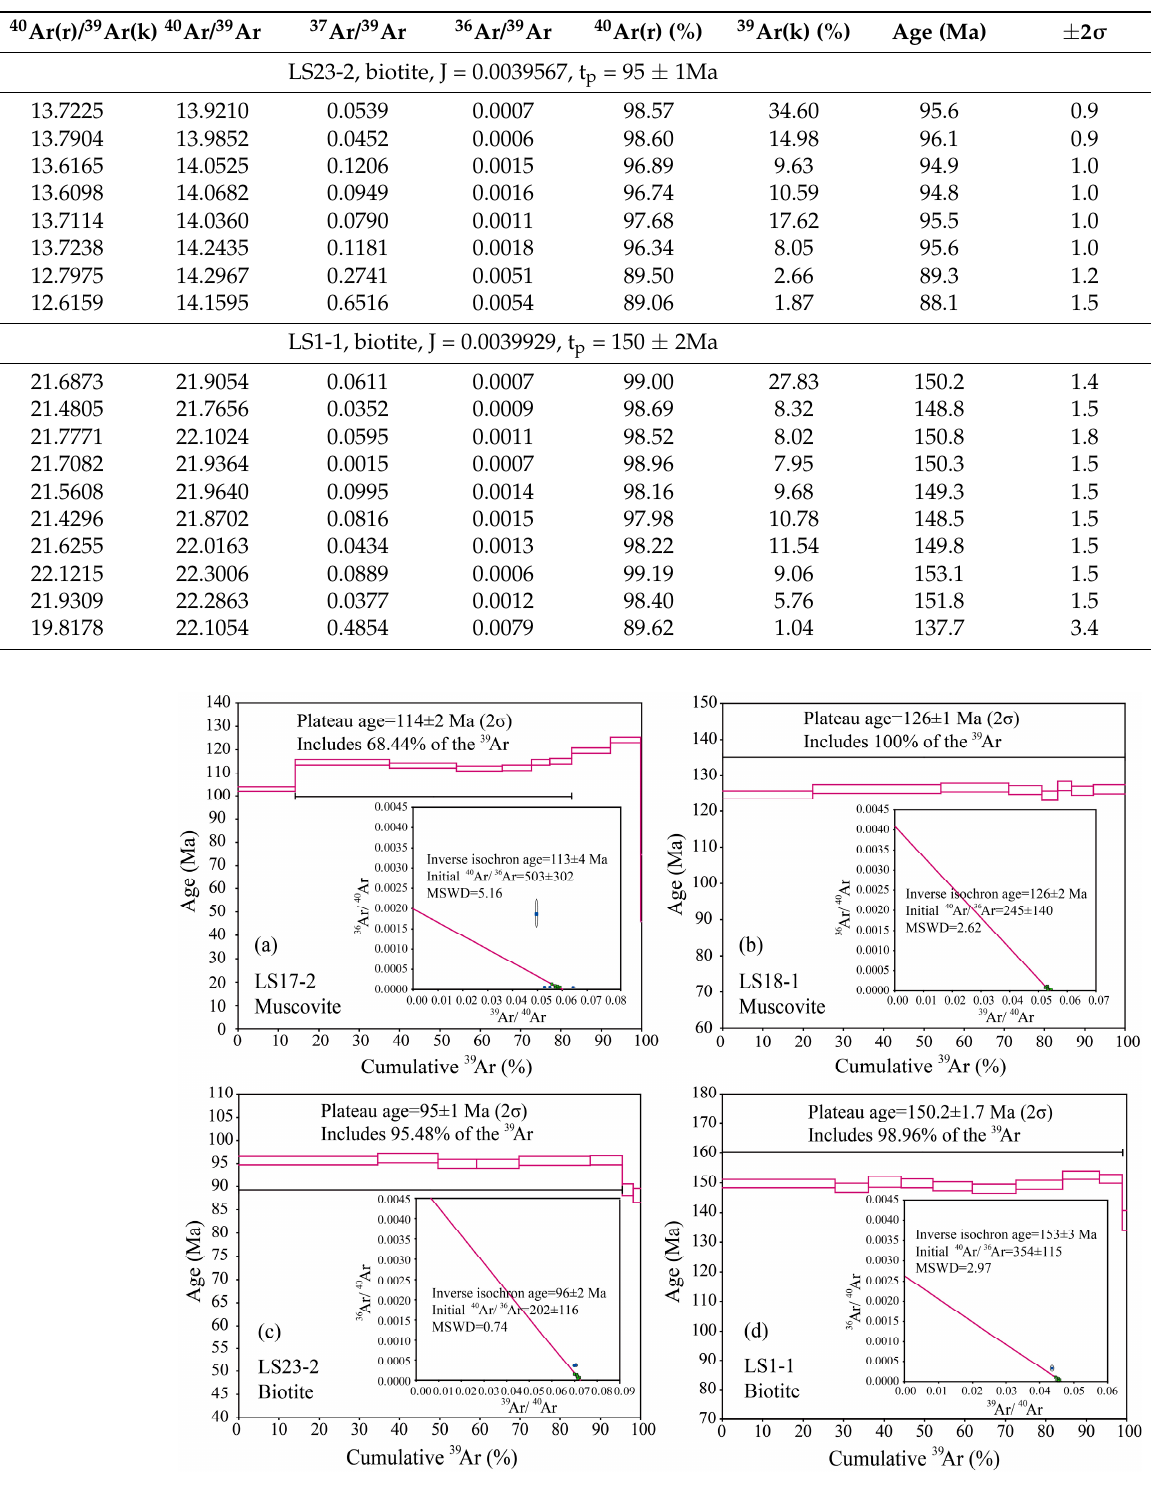
Figure 11. Plateau and inverse isochron Ar–Ar age of muscovite samples ( a , b ) from the metamorphic rocks within the WDF and biotite samples ( c , d ) from the Haihui granite and the gneiss within the Tan–Lu fault, respectively. Table 1. Ar–Ar stepwise heating data for muscovite and biotite samples.